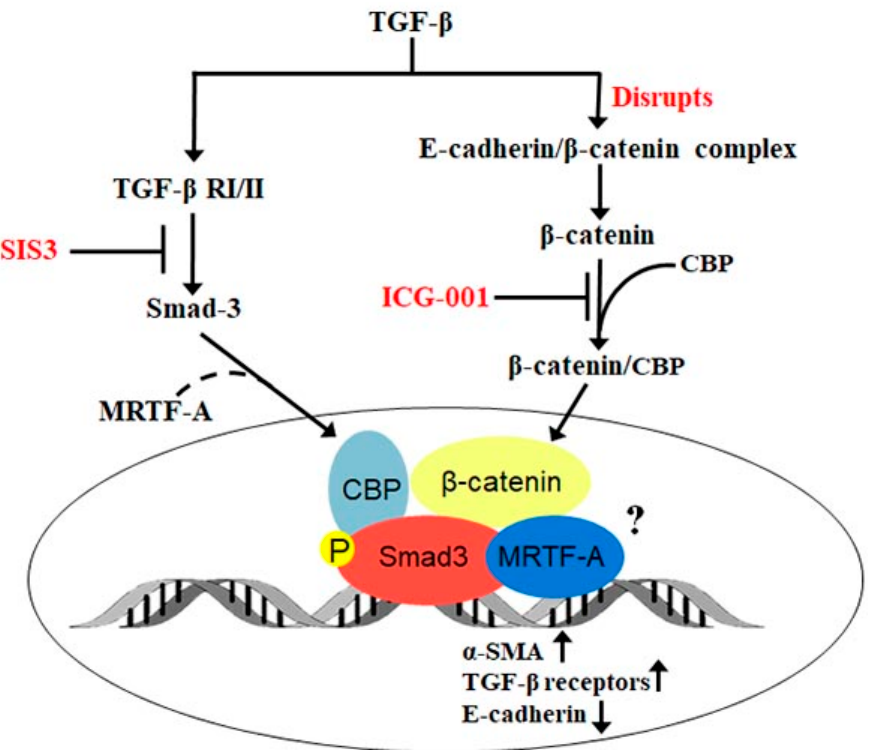
Figure 6. Schematic representation of the β -catenin and Smad3 interaction-mediated regulation of TGF- β -induced EMT in LECs. TGF- β results in activation of both canonical (Smad3) and non-canonical ( β -catenin) signaling. Upon TGF- β -induced disruption of E-cadherin / β -catenin, free β -catenin interacts with CBP and translocates to the nucleus. TGF- β -induced active Smad3 translocates to the nucleus and also regulates nuclear translocation of MRTF-A possibly through formation of the Smad3 / MRTF-A complex. β -catenin / CBP might form a complex with Smad3 and MRTF-A in the nucleus, which might then regulate EMT-related